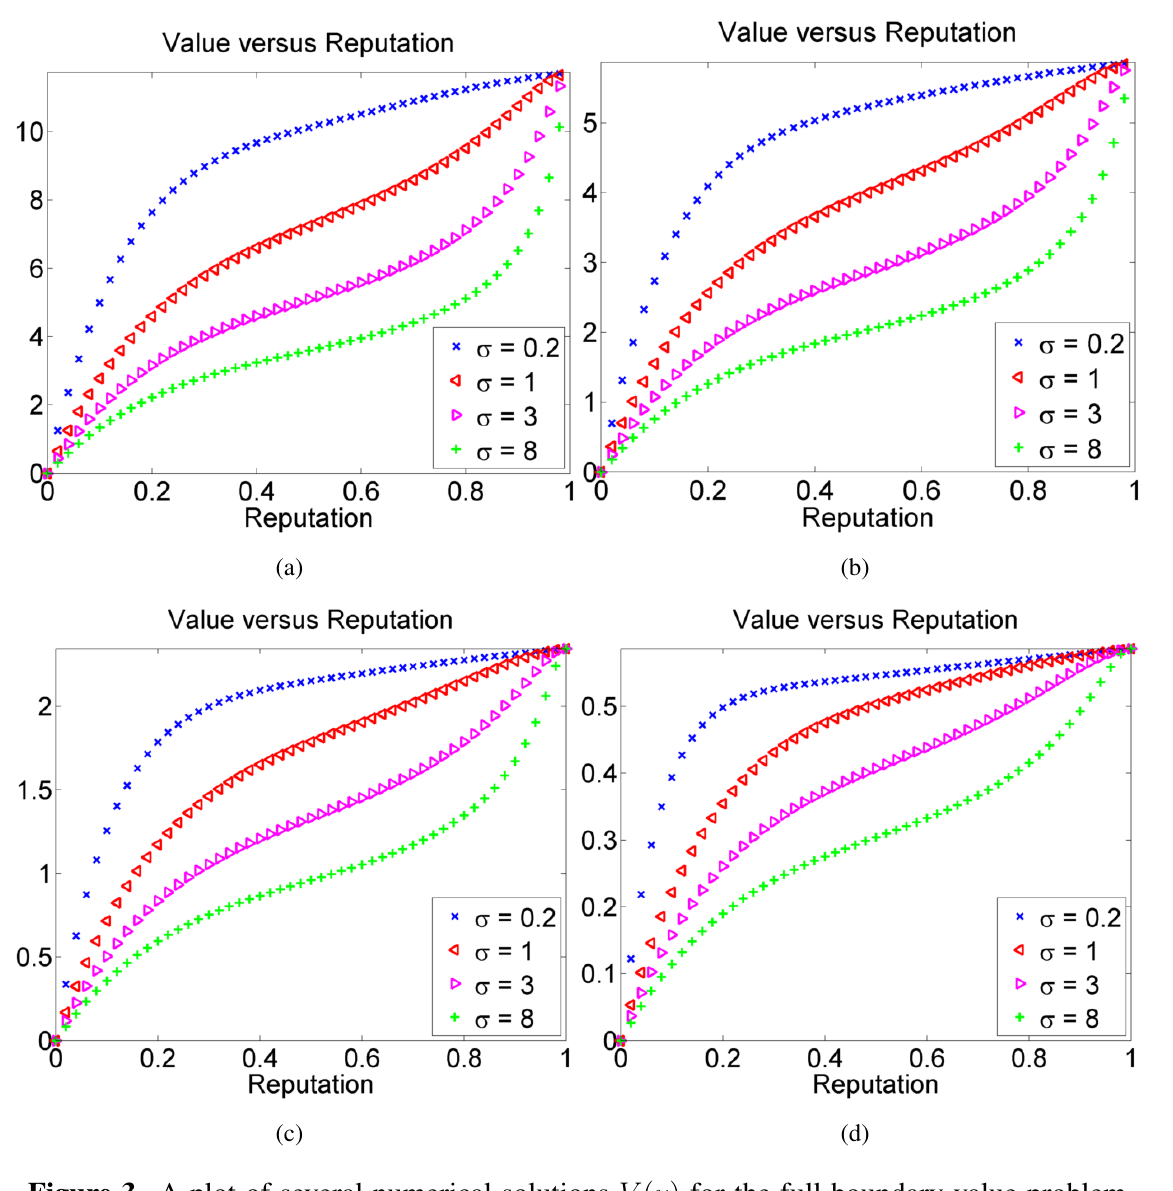
Figure 3. A plot of several numerical solutions V ( y ) for the full boundary value problem Equation (14) are shown with A = 1 , C = 0 . 15 , (cid:15) = 0 . 02 , and κ = 0 . ( a ) ρ = 0 . 1 ; ( b ) ρ = 0 . 2 ; ( c ) ρ = 0 . 5 ; ( d ) ρ = 2 . 0